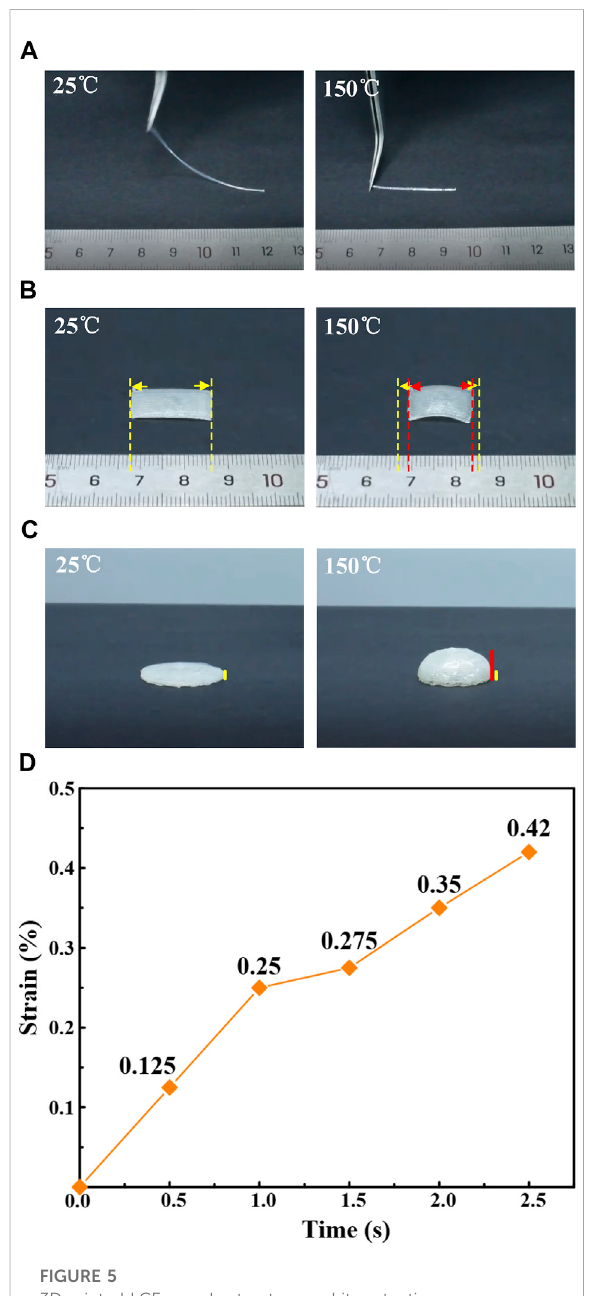
FIGURE 5 3D printed LCE sample structure and its actuation performance. The yellow line represents the original size, and the red line represents the deformed size. (A) LCE fi ber shrinks along the length direction on the 150 ° C drying table. (B) LCE fi lm contracts along the length direction on the 150 ° C drying table. (C) LCE fi lm printed in circular coating mode shrinks and bulges towards the center (side view). (D) Variation of the actuation strain of the LCE fi ber over time when heated on a 150 ° C drying